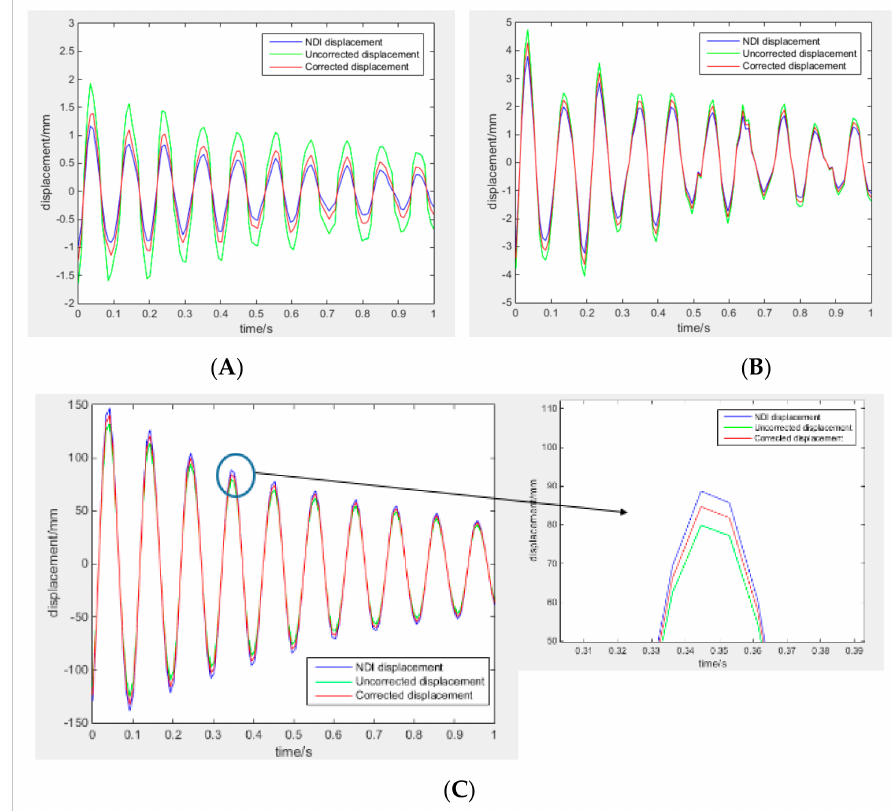
Figure 16. Comparison between deformation displacements of point C for the di ff erent time. ( A ) X -axis; ( B ) Z -axis; and ( C ) Y -axis. Table 2. Comparison of deformation along the y-axis for di ff erent time by removing the load of 20 kg loaded at the wing tip, the measured strain is obtained from the fiber Bragg grating (FBG) sensor measurement, and the actual strain is calculated from the NDI measurement with iFEM. C U are, respectively, the deformation computed from the unmodified and modified strain measurements with iFEM at point